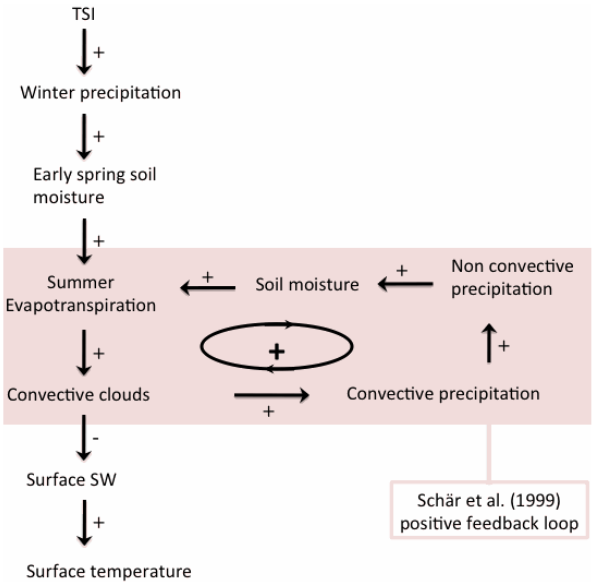
Fig. 7. Scheme of the proposed mechanism operating in Central and Figure 7. Scheme of the proposed mechanism operating in Central and Eastern Europe. The 2 Eastern Europe. The sign between the two variables at each side of sign between the two variables at each side of any arrow explains the relationship between 3 any arrow explains the relationship between them (“+” for increase them (“+” for increase and “-“ for decrease). The Schär et al. (1999) positive feedback loop 4 and “ − ” for decrease). The Sch¨ar et al. (1999) positive feedback has been highlighted in light pink. 5 loop has been highlighted in light